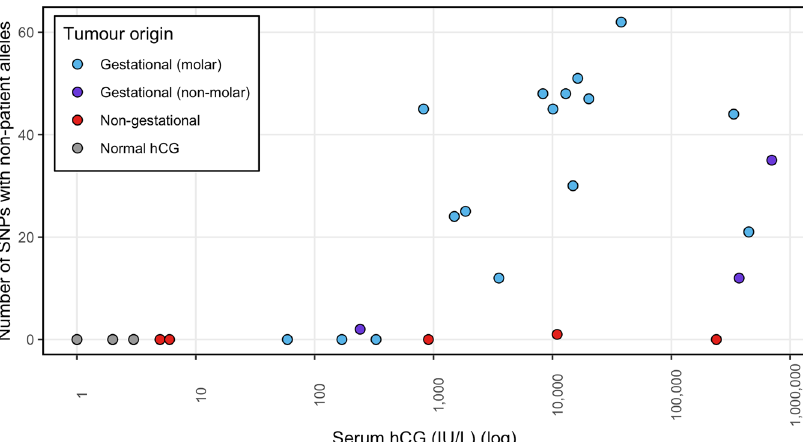
Fig. 2 Number of SNPs with non-host alleles in cfDNA from controls and tumour cases of known origin. Gestational tumour patients had ≥ 12 SNPs with non-host alleles when hCG levels ≥ 824 IU/L, but only 0-2 had detectable non-host alleles when hCG levels were ≤ 328 IU/L. Samples from patients with non-gestational tumours or normal hCG ( ≤ 4 IU/L) levels had 0 or 1 SNP with non-host